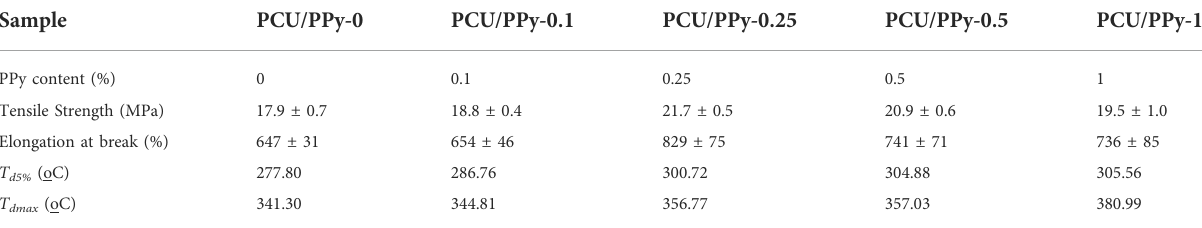
TABLE 1 Stretch data and TGA of PCU/PPy-x.